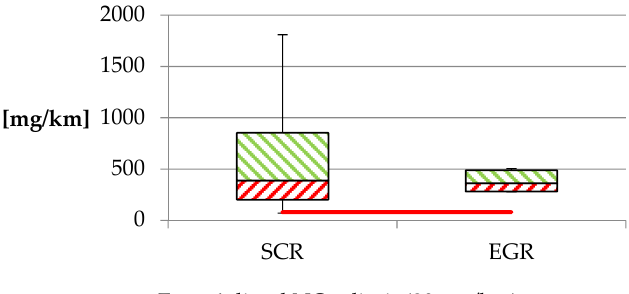
Figure 4. PEMS test results for fifteen Euro 6 diesel passenger cars according to after-treatment technology (based on [21]). Notice the huge range for the SCR emissions, for which a maximum of 1809 mg ∙ km − 1 was reported. For Euro 6 diesel cars only equipped with exhaust gas recirculation (EGR), the NO x emissions were less spread, but still many times higher than the 80 mg ∙ km − 1 limit.